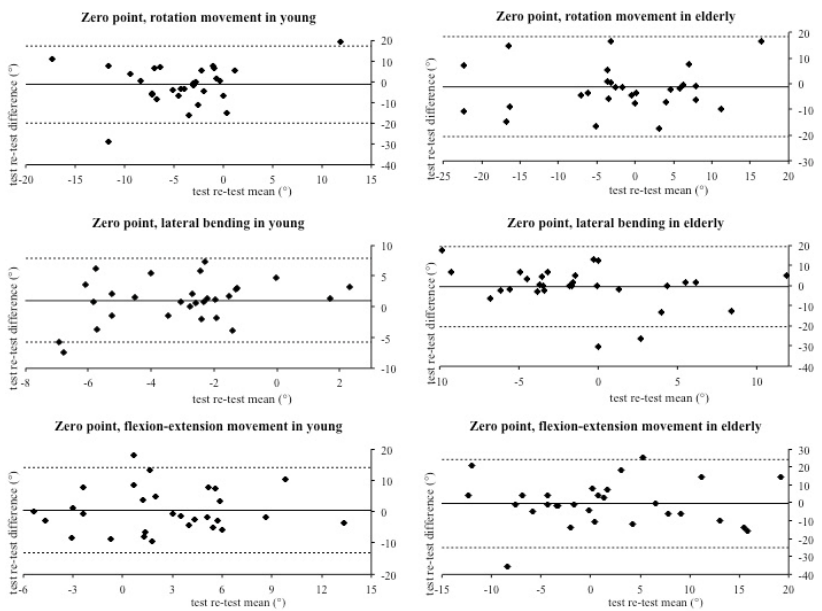
Figure 4. Bland–Altman plots of zero point in young and elderly subjects.